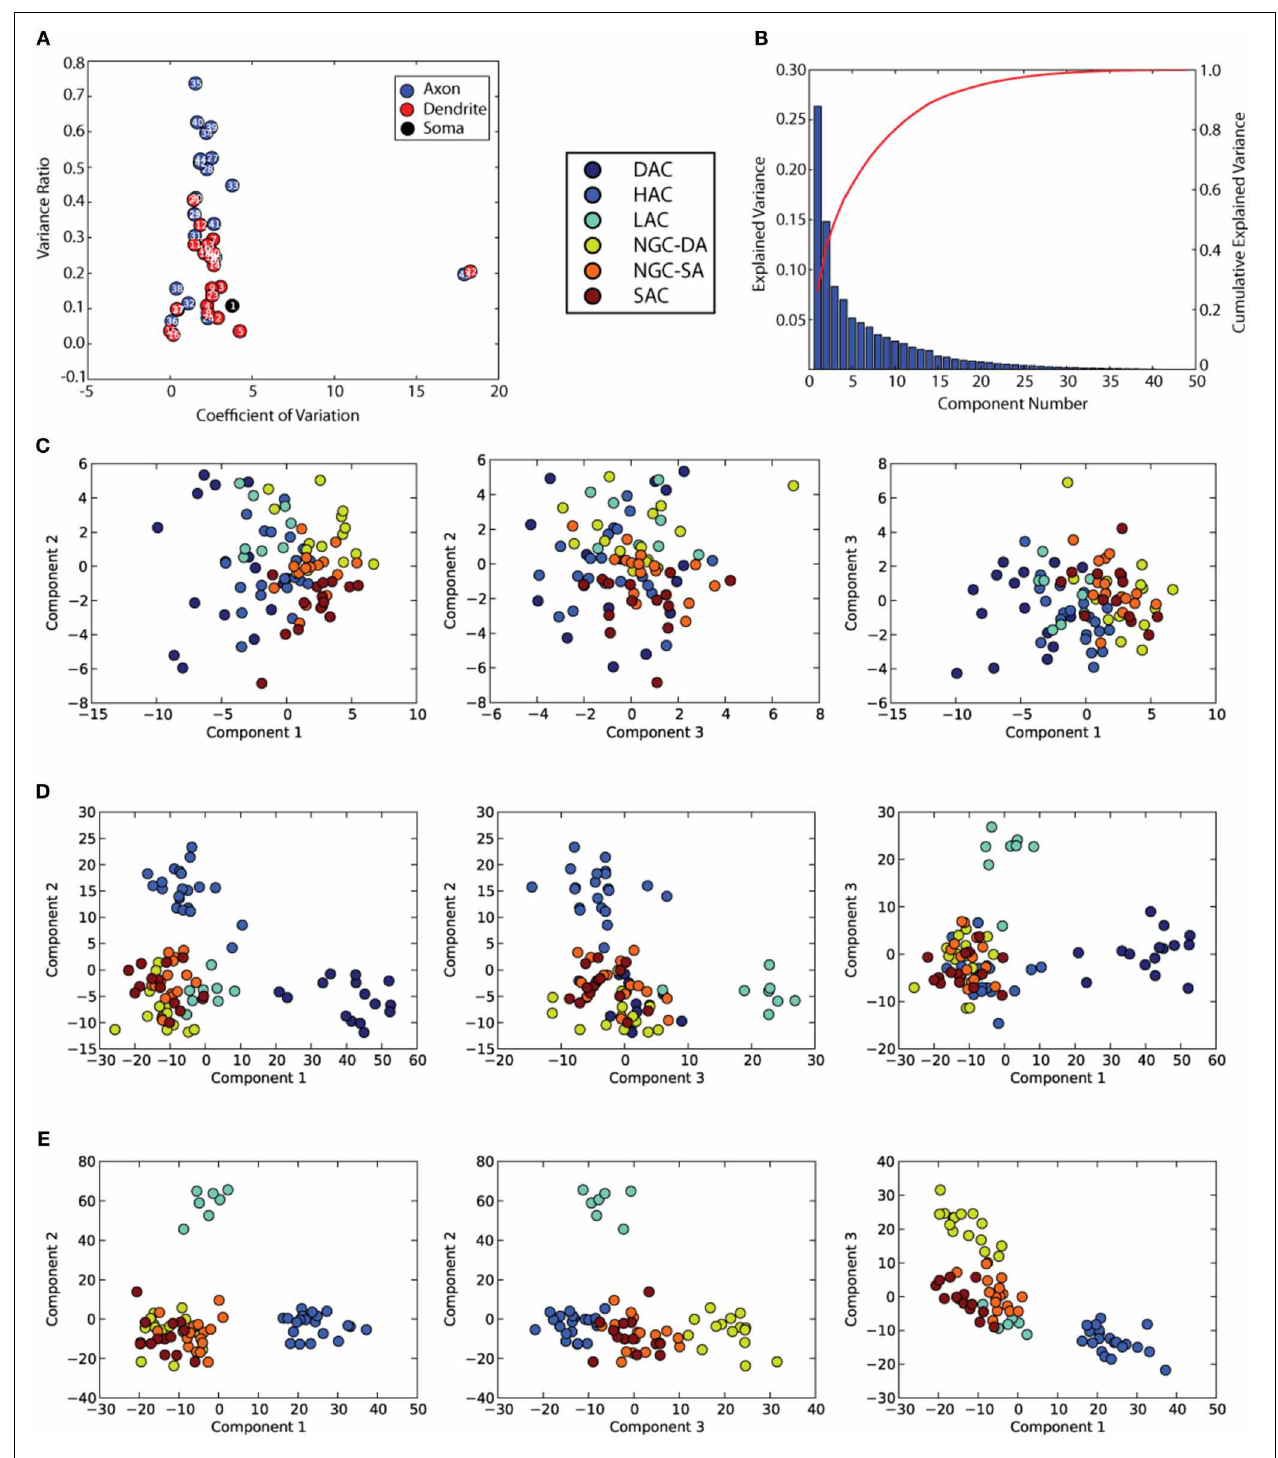
FIGURE 2 | Objective Morphological analyses of cells found in L1. (A) shows the feature power analyses which rates mostly axonal features as the most discriminative for classifying L1 cells. (B) Shows the amount of variance explained by the PCA components. (C) is the set of PCA plots done